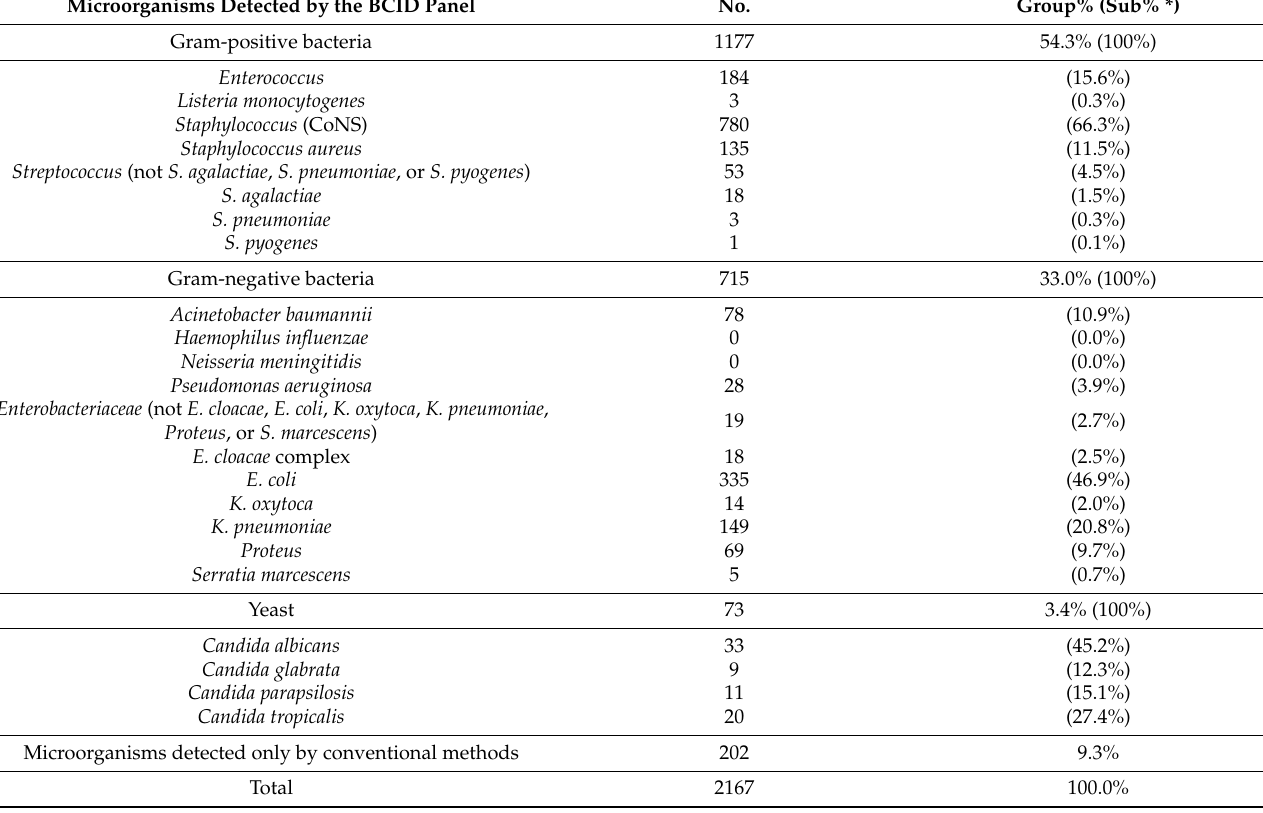
Table 1. Prevalence of microorganisms from positive blood culture bottles detected with the BCID